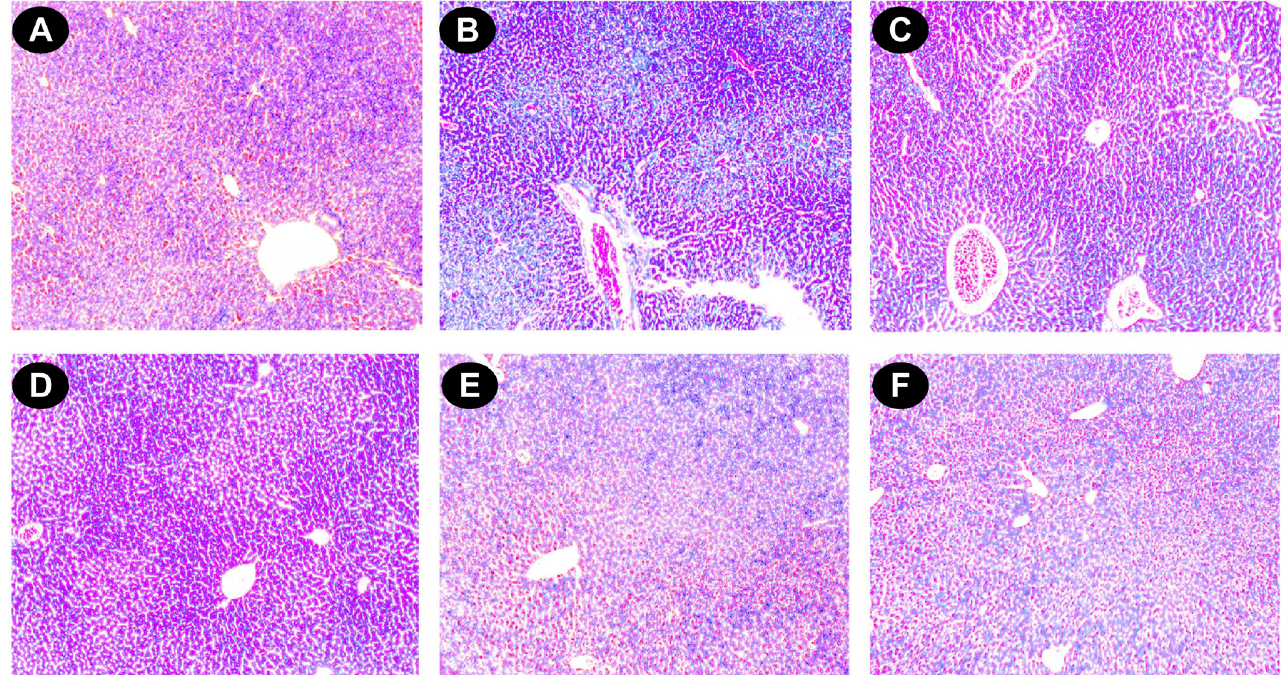
Fig 9. Photomicrograph of mice liver sections (Masson ’ s Trichrome staining) ×100. (A) Control mice liver shows normal cellular integrity with no fibrosis. (B) Iron-intoxicated (iron dextran, 100 mg/kg b.w.) liver section with elongated fibrous septa and accumulation of collagen (Blue). (C) Liver section treated with iron dextran + 50 mg/kg b.w. DBME shows slight fibrosis. (D) Liver section treated with iron dextran + 100 mg/kg b.w. DBME shows improved histology. (E) Liver section treated with iron dextran + 200 mg/kg b.w. DBME. (F) Liver section treated with iron dextran + 20 mg/kg b.w. desirox shows nearly negligible accumulation of collagen and healthy liver. S100 and S200 show reduced collagen deposition, fibrous septum and necrotic cells in periportal veins indicating a trend of restoration of normal cellular integrity.